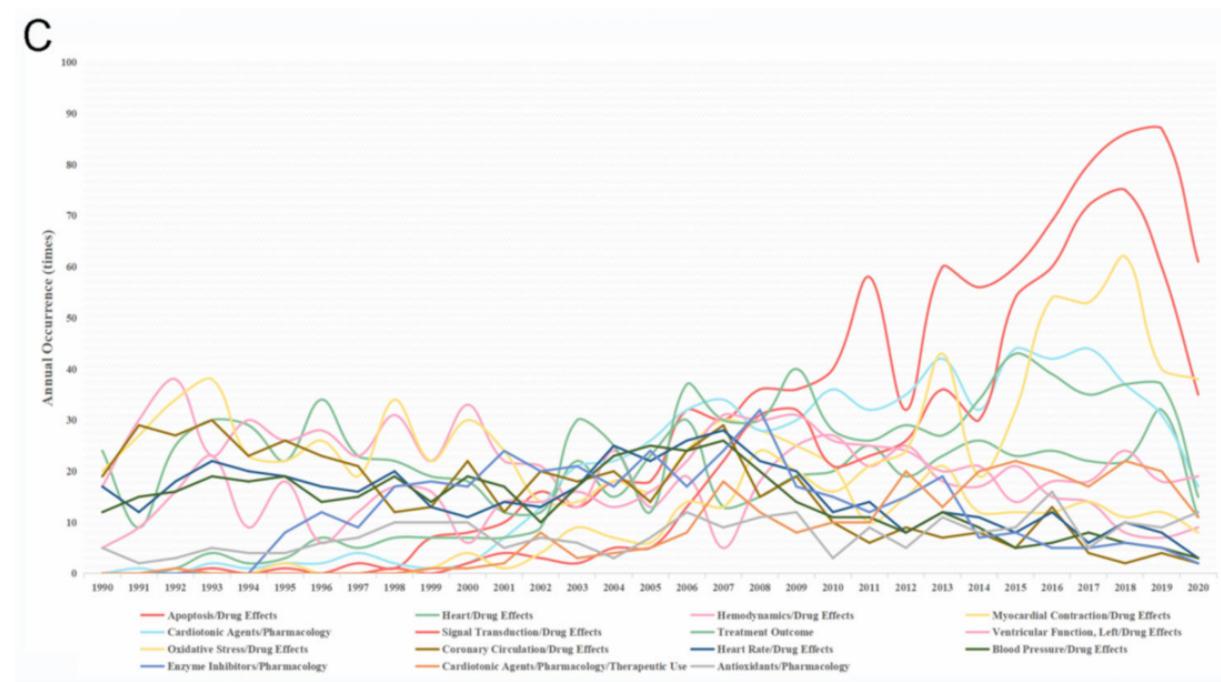
Figure 6. MeSH terms in relation to the treatment of myocardial reperfusion injury. ( A ) accumulated occurrences of the top 15 MeSH terms every ten years; ( B ) accumulated occurrences of the top 5 MeSH terms with the greatest increasing trend; ( C ) annual occurrences of the top 15 MeSH terms.